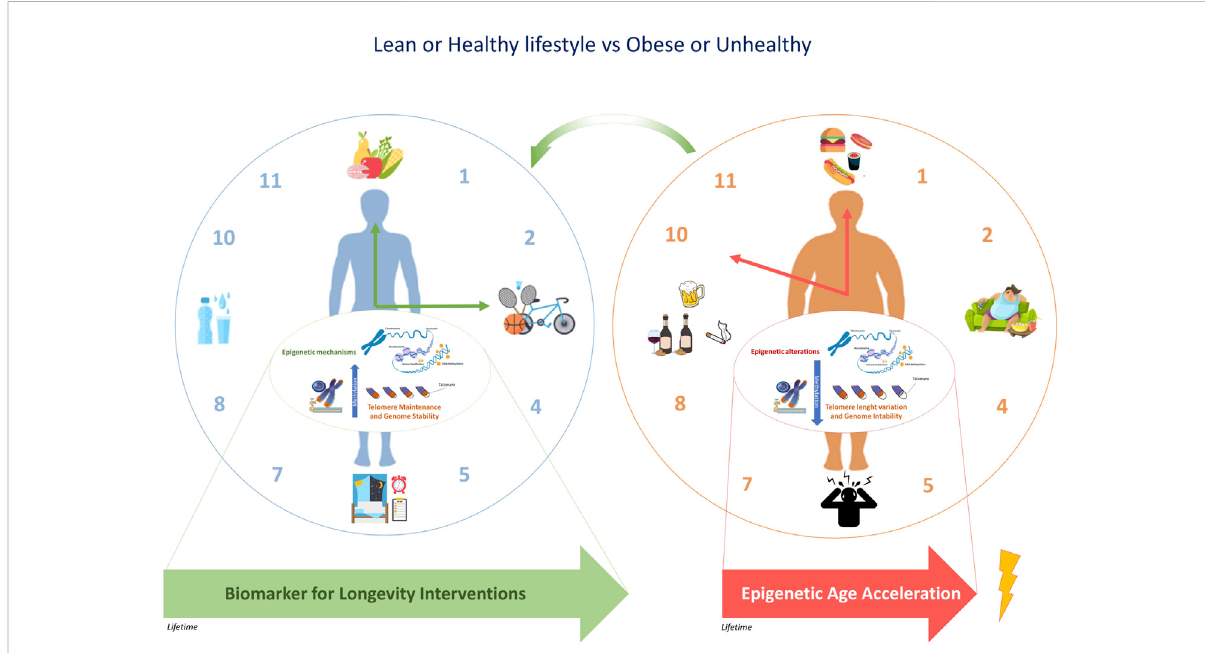
FIGURE 2 Theepigeneticclockandtelomerelengthareassociatedwithchronologicalage.Theepigeneticmodi fi cationsinducedbyanunhealthylifestyle can accelerate epigenetic aging. Due to the potential reversal of epigenetic aging, some targeted population groups, such as obese subjects might respond to changes in